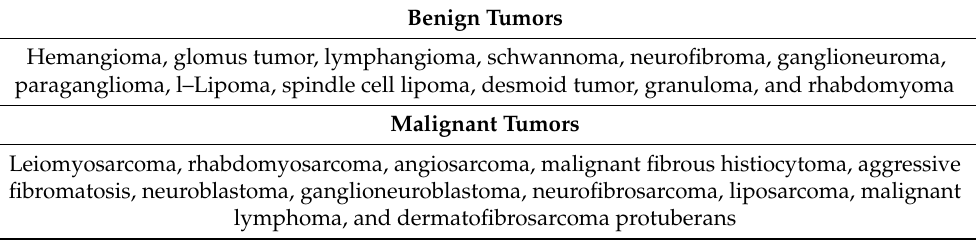
Table 2. Classification of primary soft-tissue chest-wall tumors.